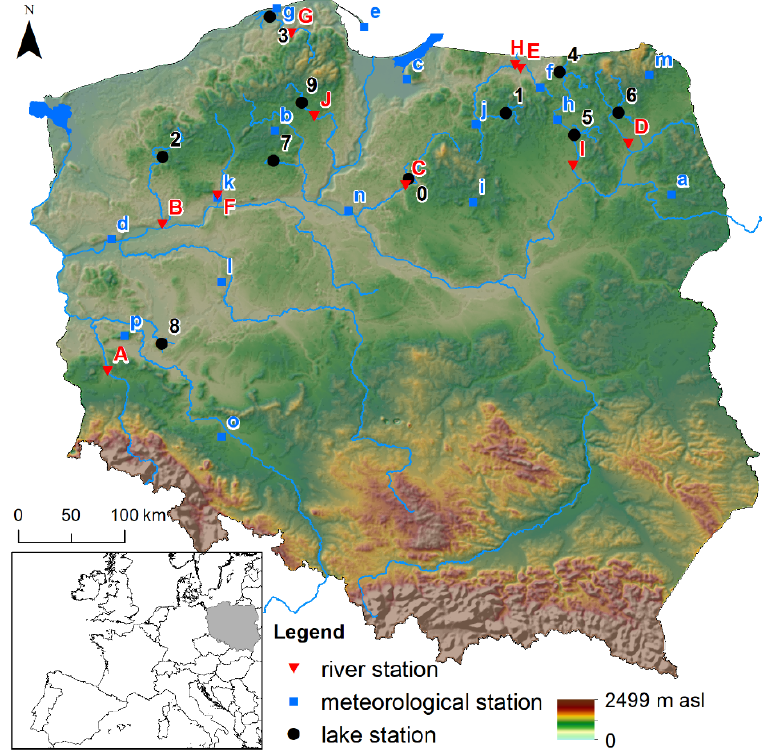
Figure 1. Locations of the analyzed river hydrological stations against the background of meteorological stations and lake stations [28] (descriptions of the stations are provided in Table 1). Developed in ArcGIS software [28] Table 1. River water temperature data—Institute of Meteorology and Water Management—Na- tional Research Institute. The locations of the stations are shown in Figure 1.